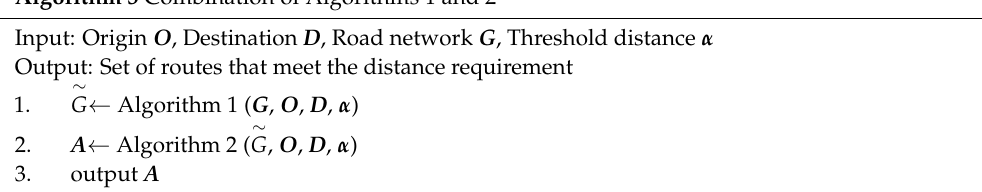
Algorithm 2 beat Algorithm 1 in most cases to be tested. Algorithm 3’s performance